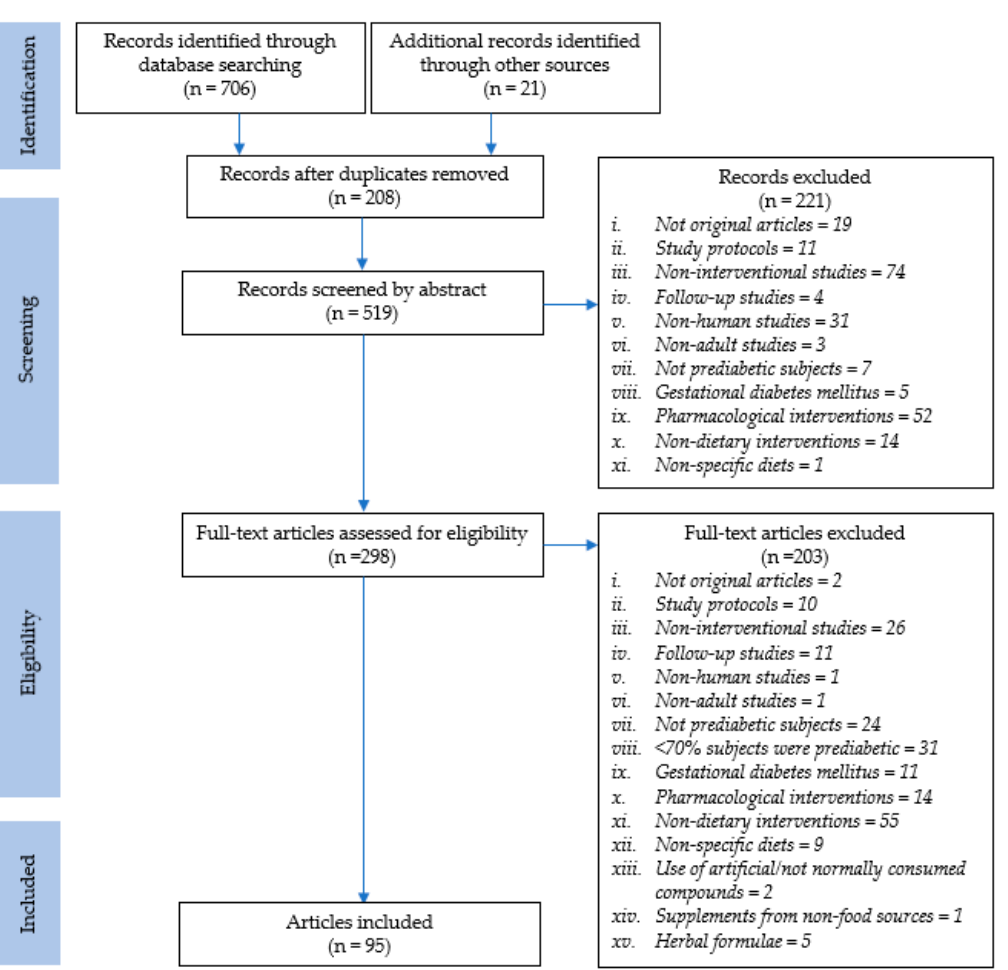
Table 2. Intervention characteristics. Characteristics